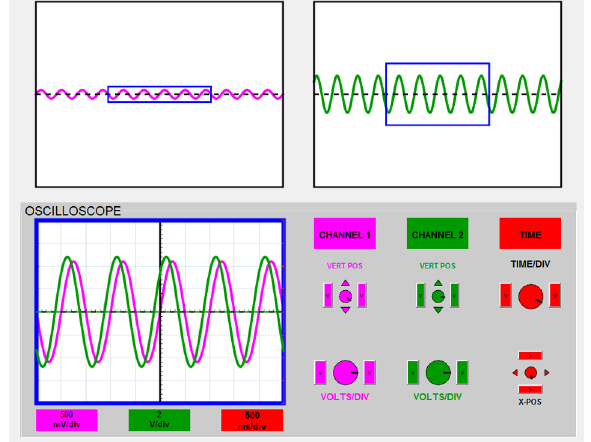
FIG. 4. Original oscilloscope simulator. The screens on top show the “ total ” signal, with portion shown on the oscilloscope screen in the blue